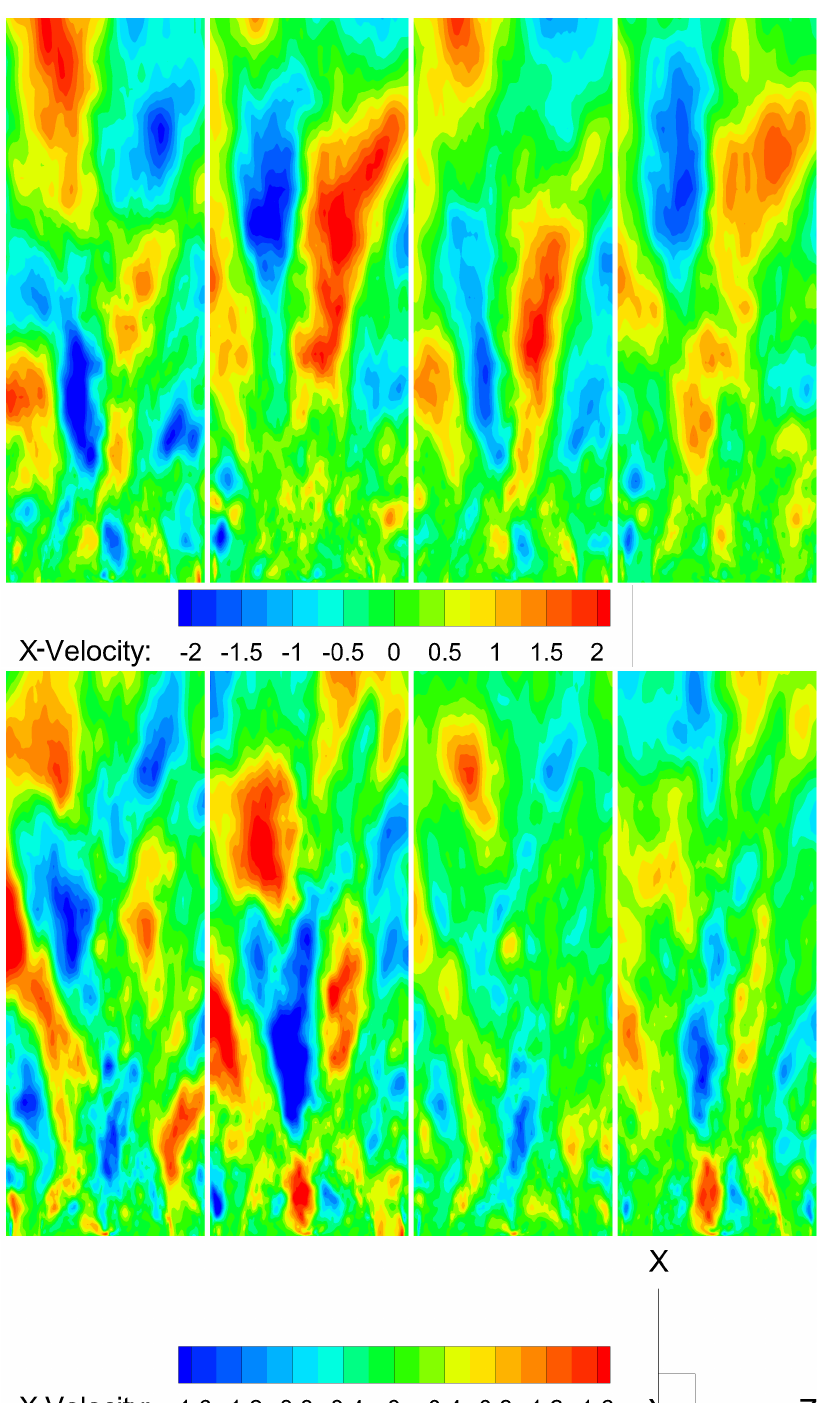
Figure 5. Axial component [ m / s ] of the two most harmonically correlated mode pairs using 3D and 2D ROM. The top four pictures correspond to mode pair 1 with a Strouhal number of 0.0311 and 0.0307 for the 3D and 2D ROM respectively. The bottom four pictures correspond to mode-pair 2 with a Strouhal number of 0.0729 for both the 3D and 2D ROM. The first two columns show the two modes of the pair for the 3D ROM, while the last two columns correspond to the 2D